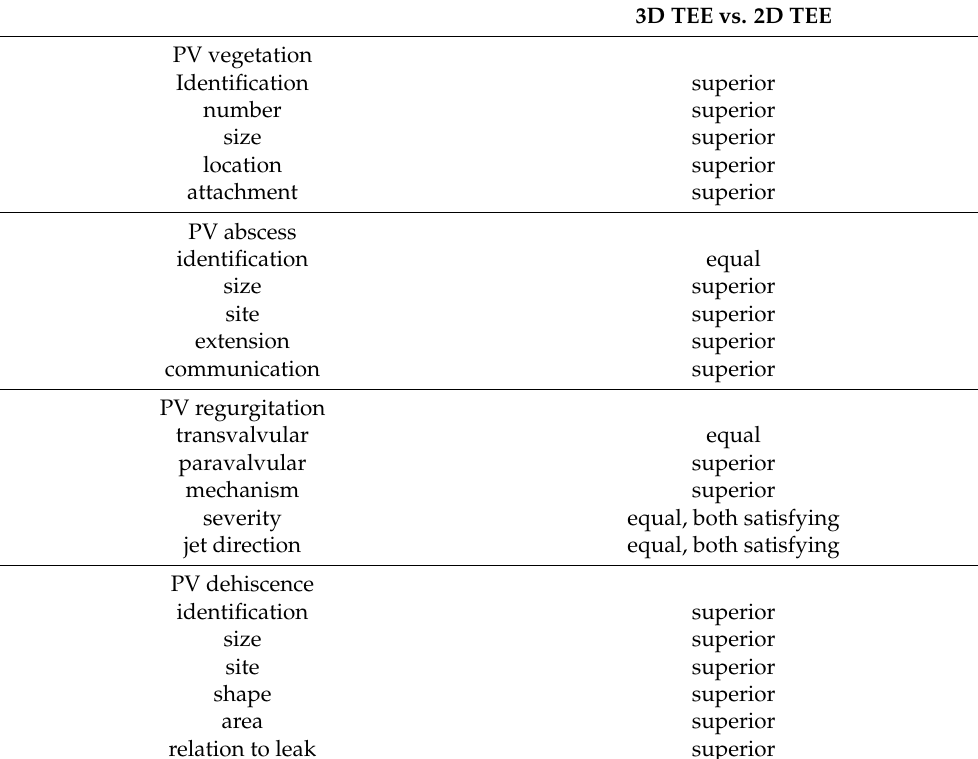
Table 1. Comparison between 2DTEE and 3DTEE in diagnosing of different prosthetic valve endo- carditis pathologies (modified according